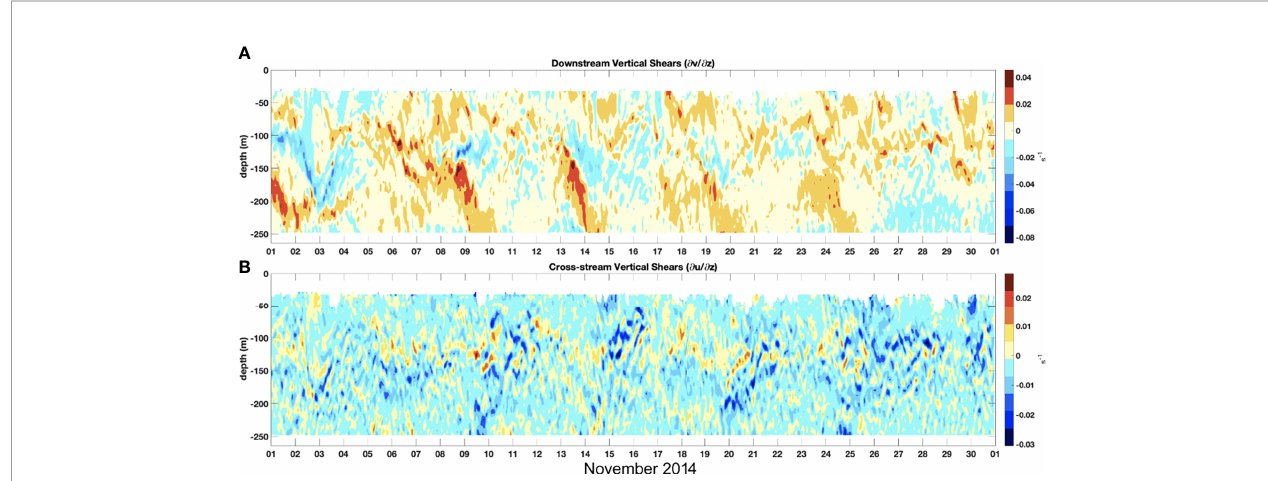
FIGURE 6 | ADCP downstream v/ z) (A) and cross-stream ( u/ z) (B) vertical shears, with zero current/shear contours in